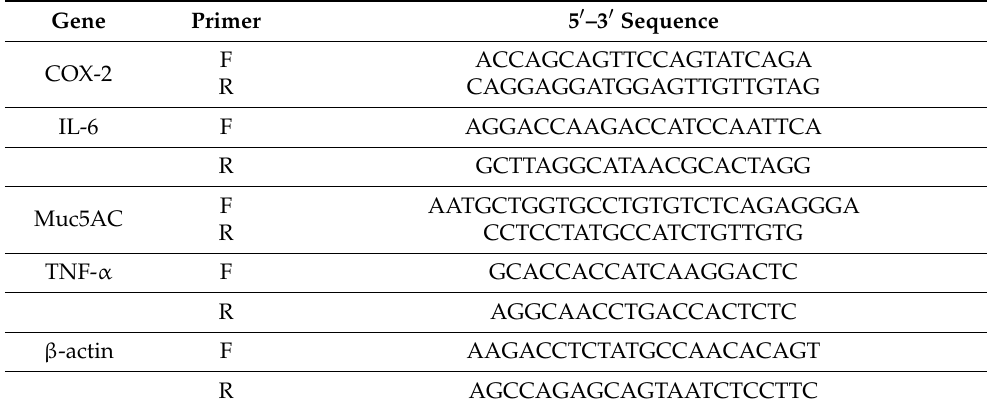
Table 1. Sequences of primer pairs used for real-time PCR. Forward (F); Reverse (R). Gene Primer 5 (cid:48) –3 (cid:48)